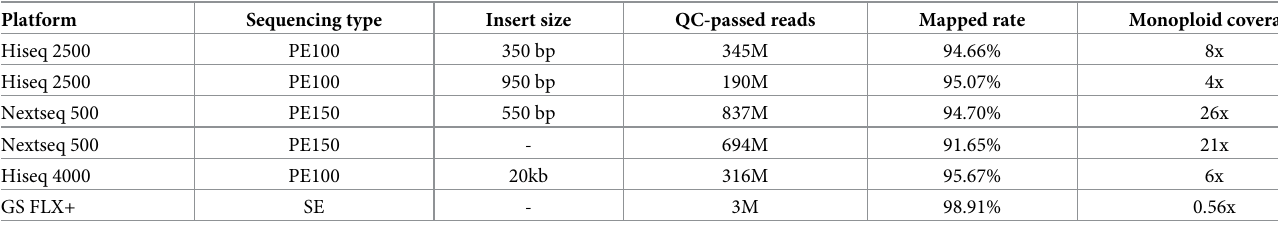
Table 1. Sequence library